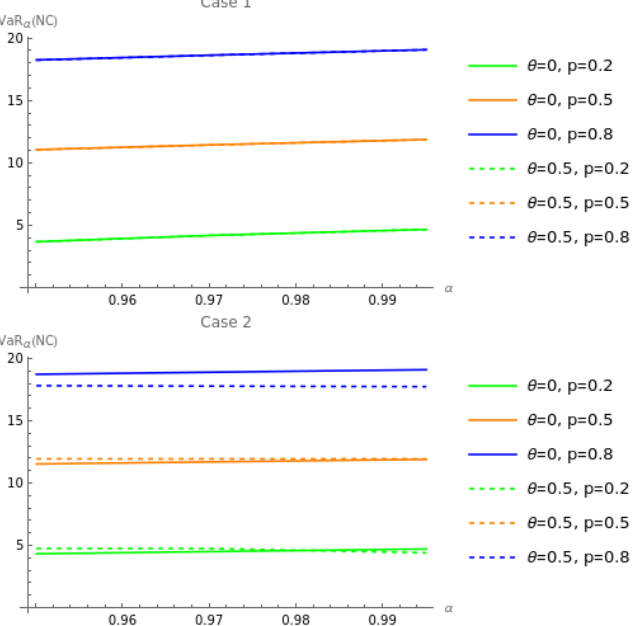
Figure 6. Effects of θ = 0 versus θ = 0.5 on VaR α ( NC; c ∗ , d ∗ , υ ∗ ) under the EVPP when p =